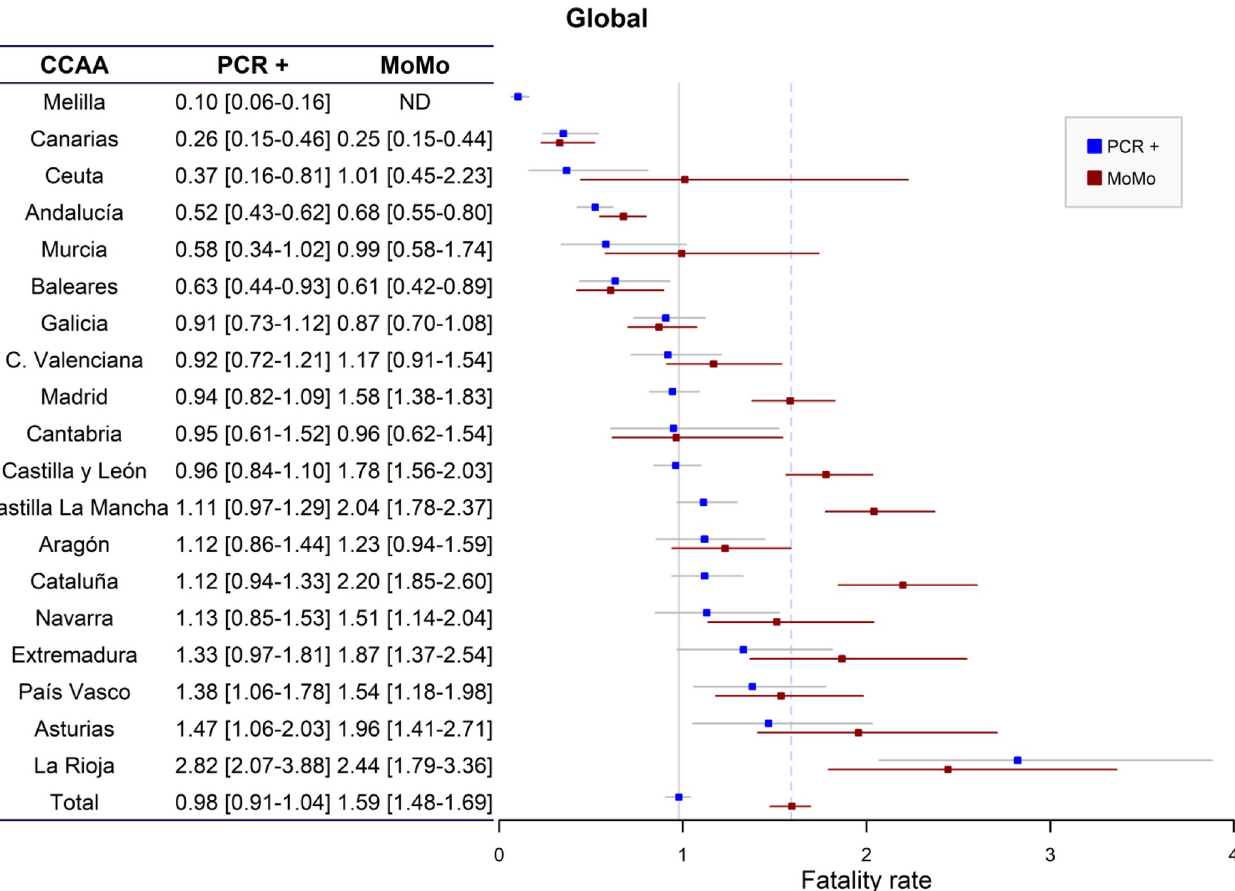
Fig 1. Case fatality rate with their ranges according to prevalence of infection calculated by official number of deaths (PCR+) and by excess mortality (MoMo) in the different Autonomous Communities (CC.AA).